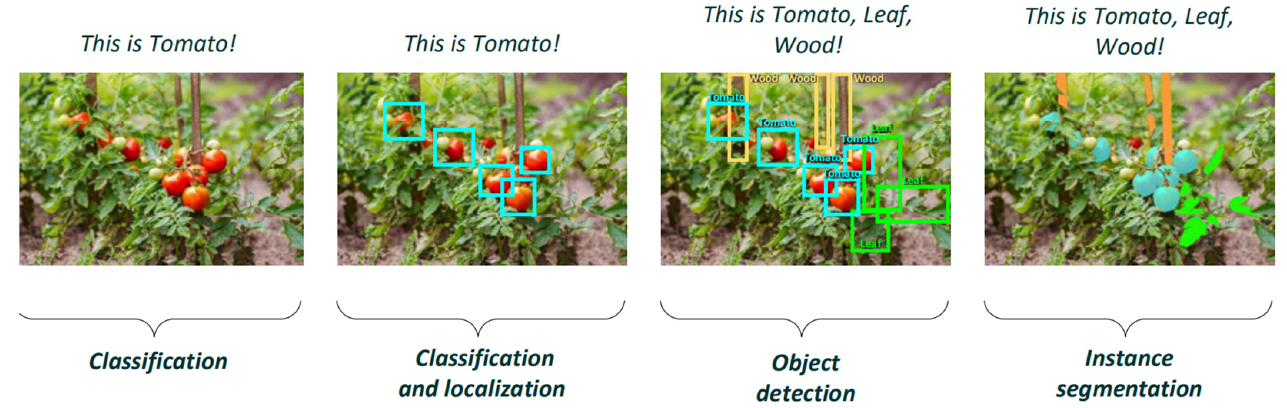
Figure 7. Object classification, localization, detection, and instance segmentation using image processing algorithms in agricultural robots [131].